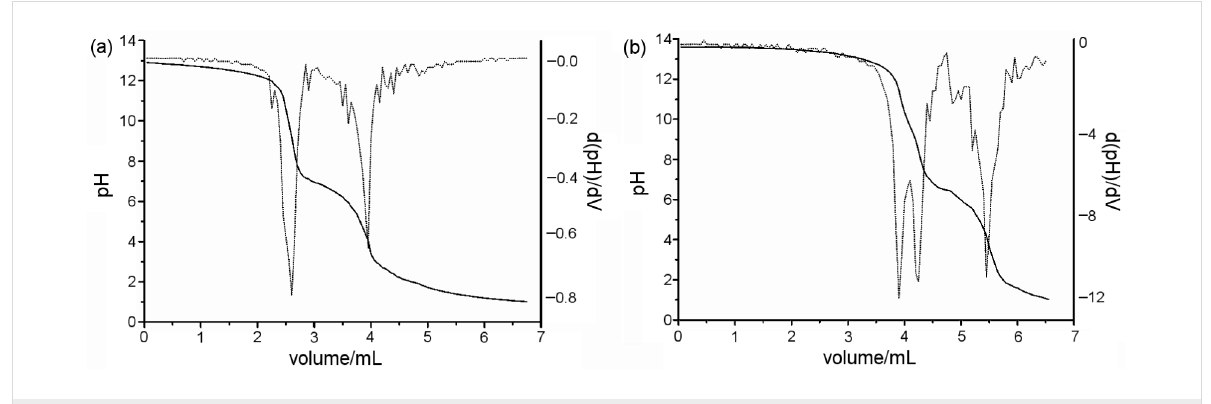
Figure 4: Potentiometric curves of the (a) Fe-Ni/Zn and (b) Fe-Ni/Zn/ β CD.